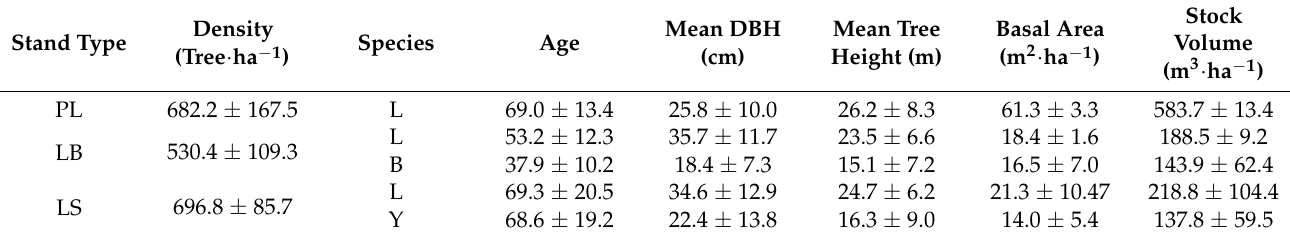
Table 1. Basic conditions of the sampling